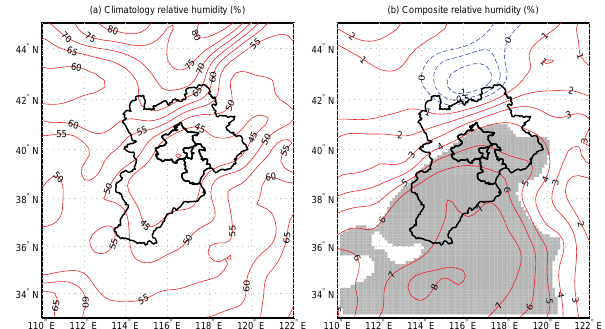
Figure 8. Same as Fig. 7 but for relative humidity.